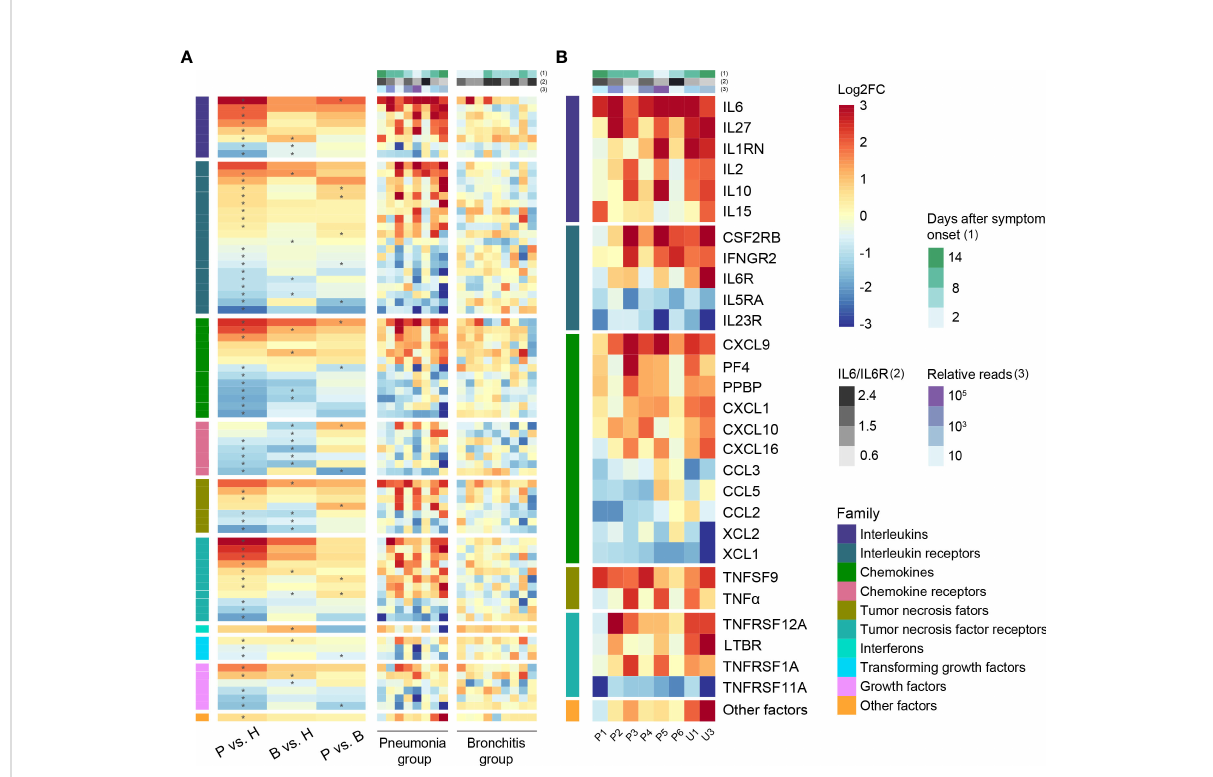
FIGURE 3 Cytokine-related gene expression in C. psittaci cases. (A) Heatmap of DEGs encoding cytokines and chemokines. (B) Heatmap of representative DEGs encoding cytokines and chemokines in PBMC of the pneumonia case samples ( n = 8). Asterisks (*) indicate signi fi cant DEGs (absolute log2FC ≥ 1, p -value < 0.05). The ratios of IL6 to IL6R and relative reads are shown in (A, B)